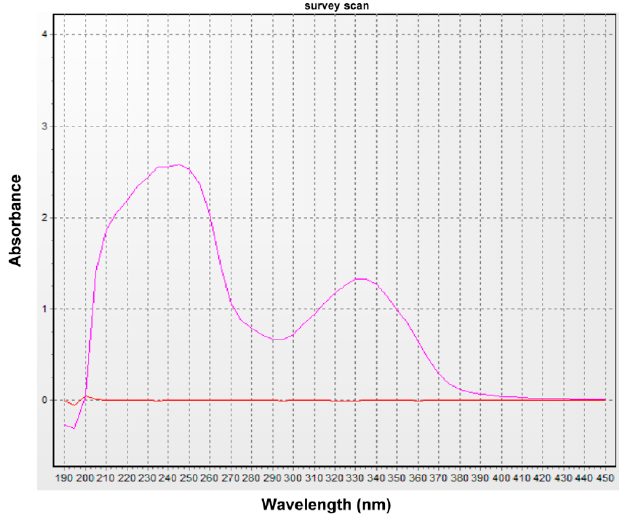
Figure 1. UV spectrum of ELF000039 crude extract after 28 days of culture. The orange line is the UV spectral baseline of the solvent (ethanol).